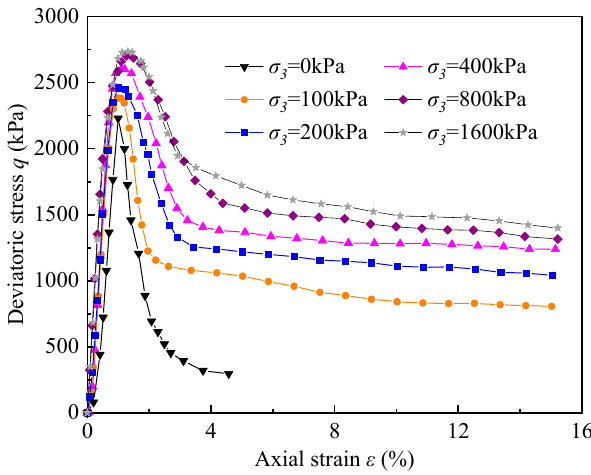
Figure 3. Stress–strain curves of cemented soil after being cured for 28 days (cement content: 18%).